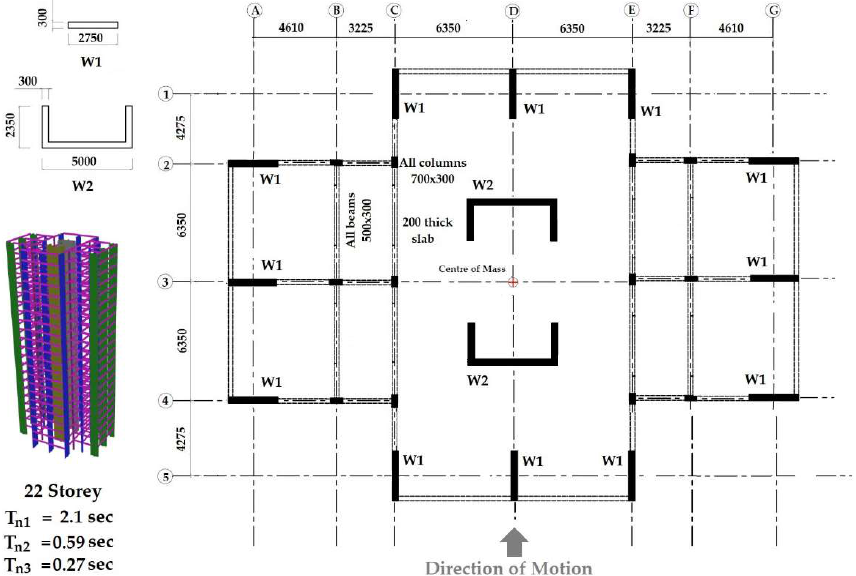
Figure 6. Structural layout (showing positions of the frame, and walls W1 and W2), structural de- tailing, and elevation of case study building CSB 2 (all dimensions are in mm). Table 2. Details of the storey height and storey masses of the case study buildings.